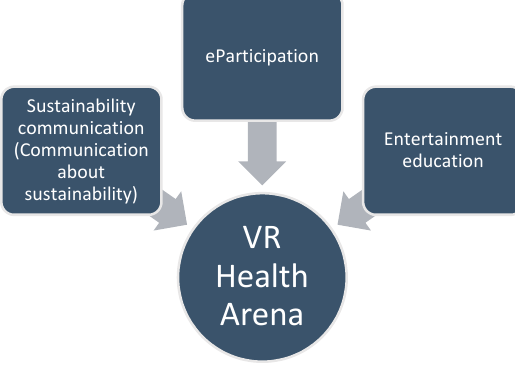
Figure 3. The concept of the Virtual Reality (VR) Health Arena could be seen in line with three streams of research on sustainability (own